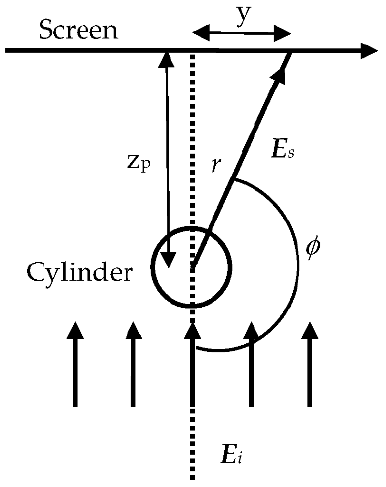
Figure 4. Geometric scheme for the rigorous method. Figures 5 and 6 show the comparison of both theories for a circular cylinder. The intensity pattern was calculated at a screen that was positioned at an axial distance that was varied in the simulations. The wavelength of the incident light was chosen to be 633 nm, while the radius of the cylinder was considered as 30 µ m in the case of Figure 5 and 80 µ m in the case of Figure 6. It can be observed that the behavior of both curves, one obtained by using the Fresnel approximation and the other by using the rigorous solution, behaved in the same manner as a function of the axial distance. Both models gave basically the same results, but it was clear that the higher the distance to the screen, the better the agreement between both models. This is due to the fact that the Fresnel approximation works better for lower values of the Fresnel number (NF) [8], which is defined as: